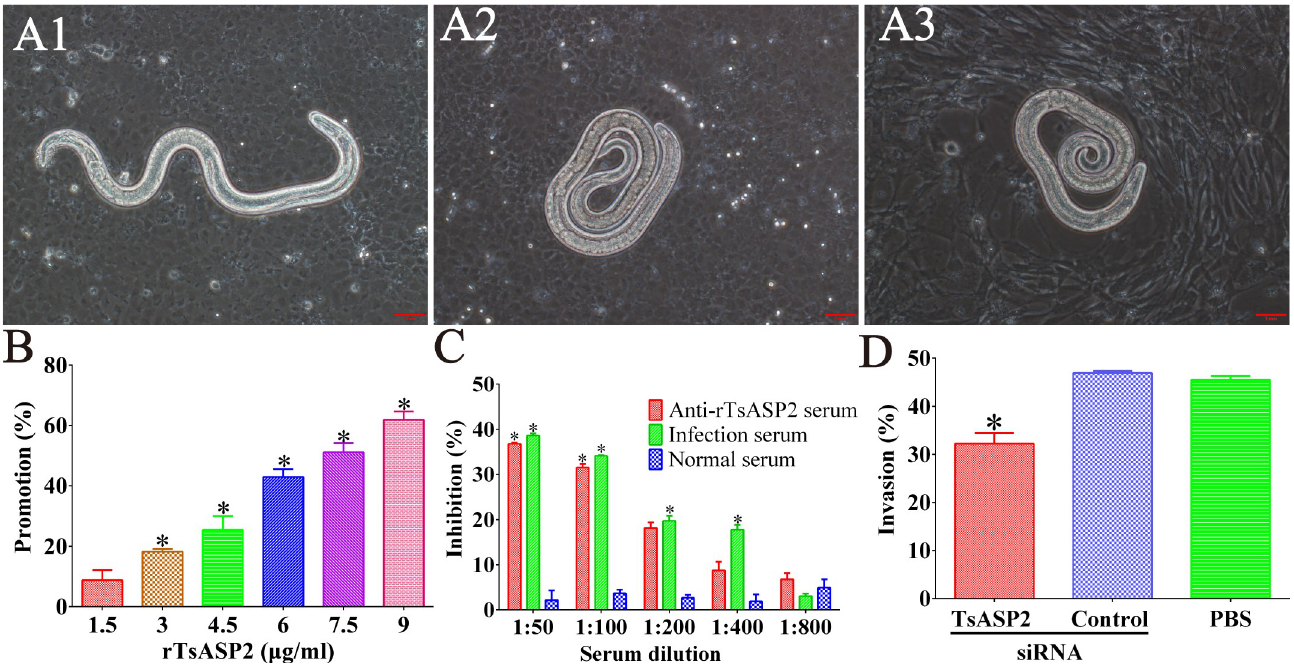
Fig 9. The invasion process of IECs by T . spiralis worms and RNAi inhibition on larval invasion of IEC. A1: The larva that invaded the IEC monolayer was mobile, and its migrating trail was observed. A2: The non-invaded larva was coiled. A3: Non-invaded larva in the C2C12 monolayer. B: Promotion of larval penetration of IECs by different concentrations of rTsASP2 protein, where significant differences ( P < 0.05) are marked with asterisks ( � ) relative to the blank control group without rTsASP2. C: Inhibition of larval invasion of IECs by different dilutions of anti-rTsASP2 serum and infection serum, where significant differences ( P < 0.05) are marked with asterisks ( � ) relative to the normal serum group. D: Larval penetration of IECs by worms treated with siRNA. Scale bar: 1